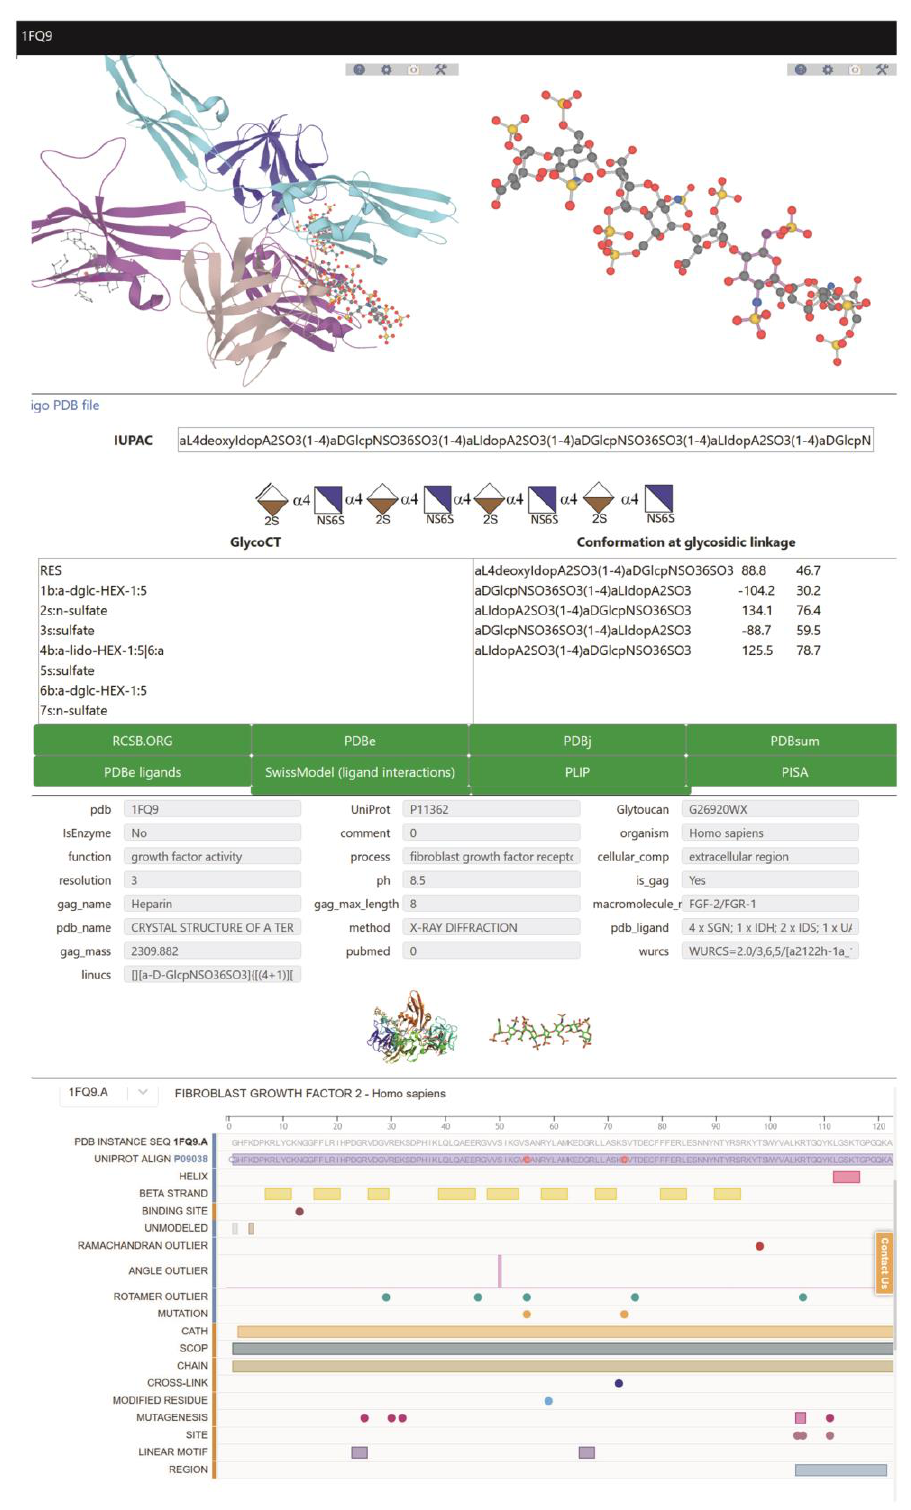
Figure 3. Full results from the search on GAG oligosaccharide present in the database using 1FQ9 in the PDB field. More information can be obtained by clicking on the green bars.